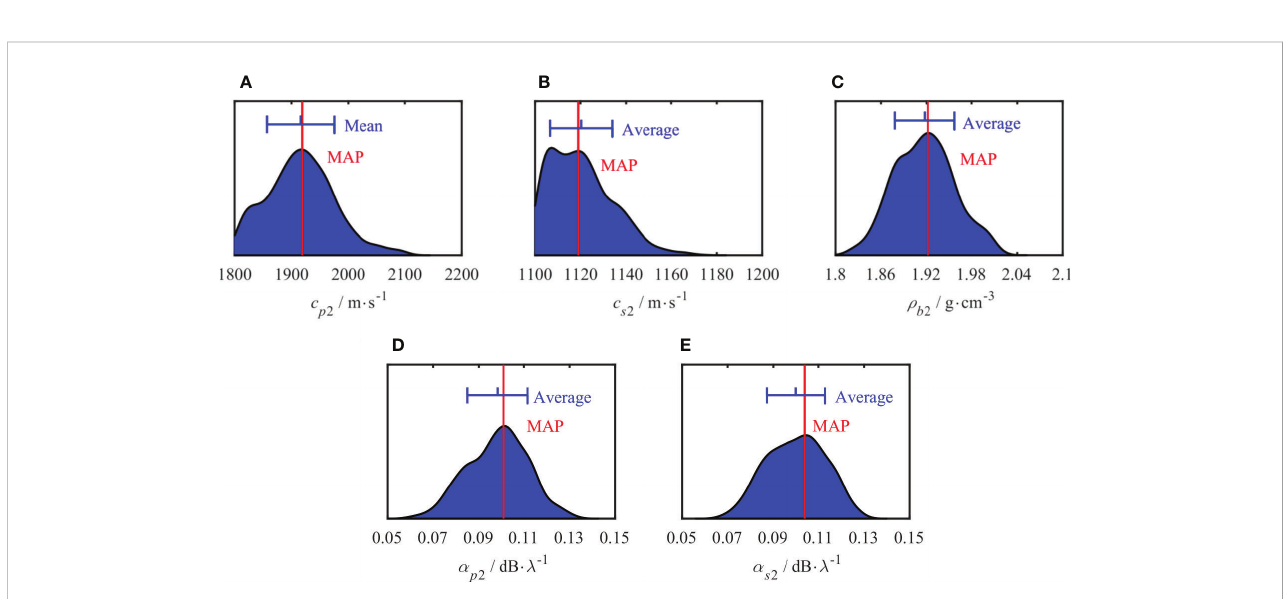
FIGURE 16 One-dimensional marginal probability distribution of semi-in fi nite parameters. MAP value (red line), Average (blue vertical line in the middle) and standard deviation (blue vertical lines at both